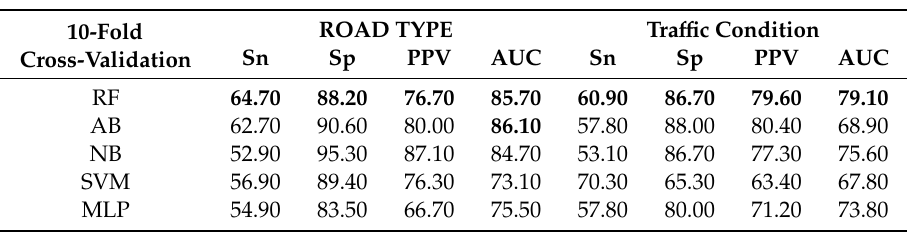
Table 8. Comparison of performance (%) with other